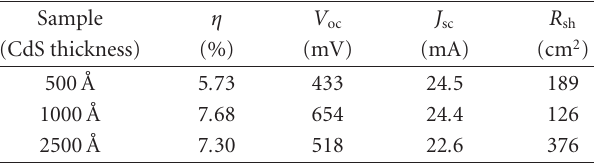
Table 3: Properties of CdS/CdTe solar cells prepared with di ff erent CdS film